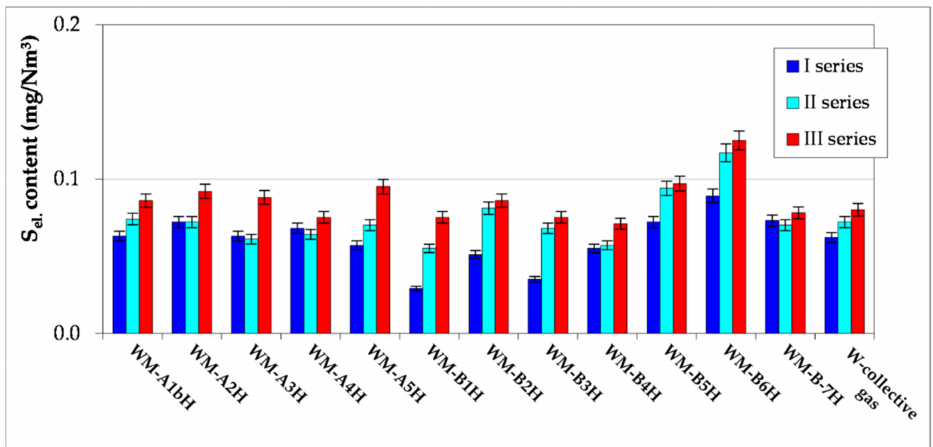
Figure 7. A comparison of the total content of organic sulphur compounds converted to Sel. in natural gas from individual horizontal wells of the Wierzchowice Underground Gas Storage facility in the XXV exploitation